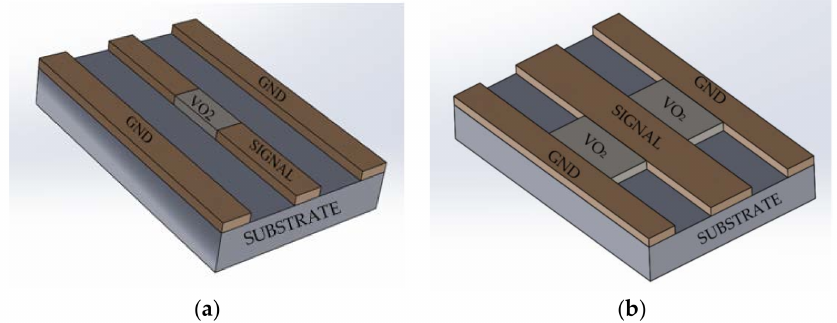
Figure 8. A generic VO 2 Based Co-Planer Waveguide (CPW) RF Switches ( a ) Series Type ( b ) Shunt Type. Thermally Triggered RF